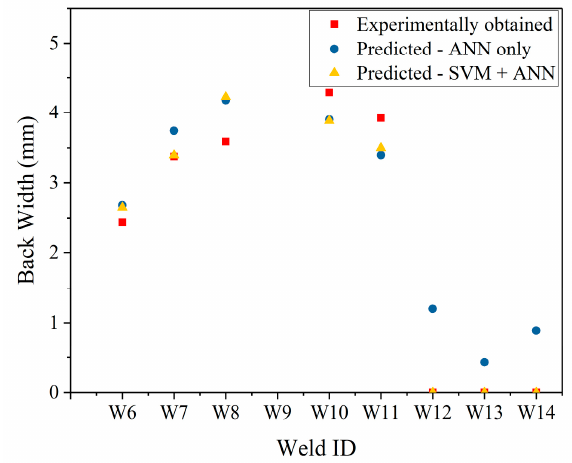
Figure 10. Comparison of the experimentally obtained and predicted BW using the ANN-only and SVM–ANN models for welds W6 to W14 in Table 4.